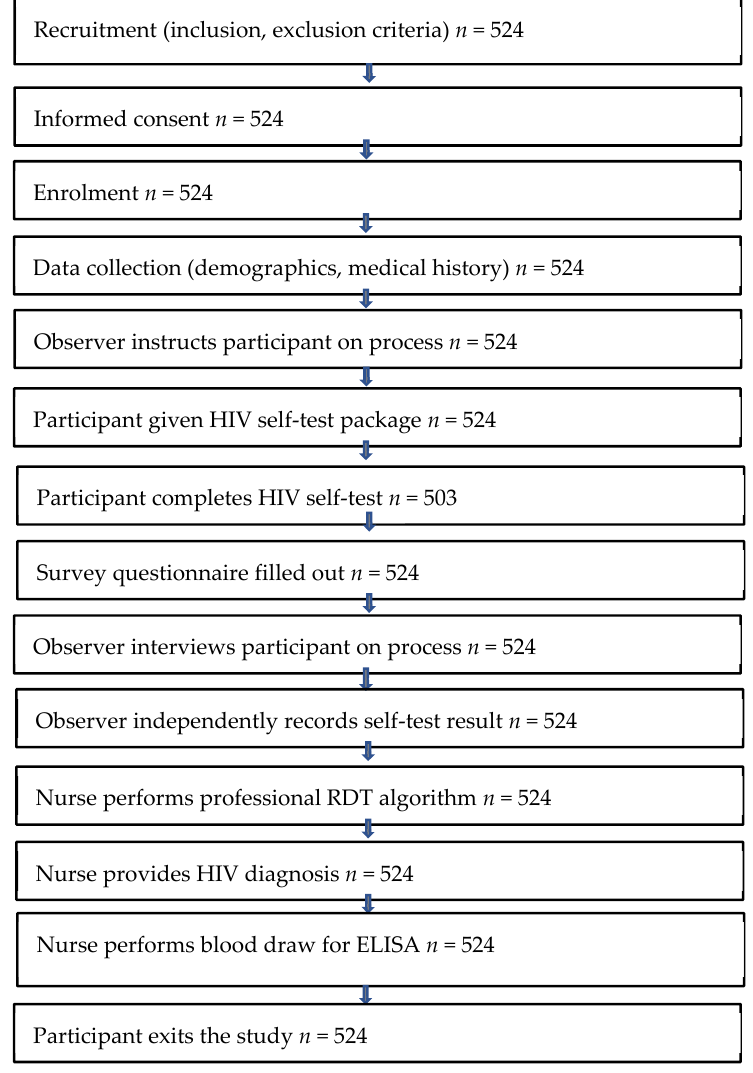
Figure 1. Sample sizes used in calculations.